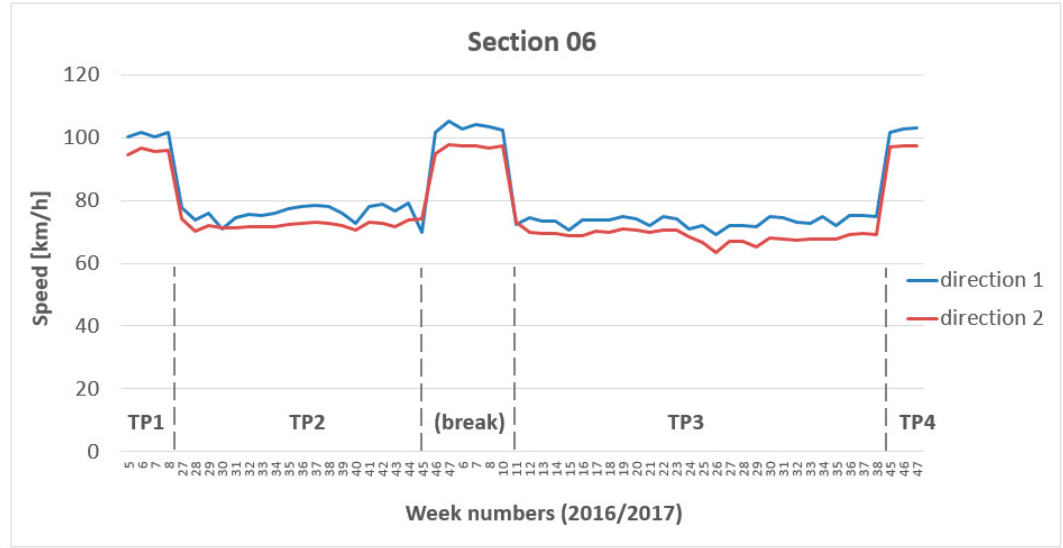
Figure 3. Example of a speed profile “in time” (TP denotes analysed time periods).